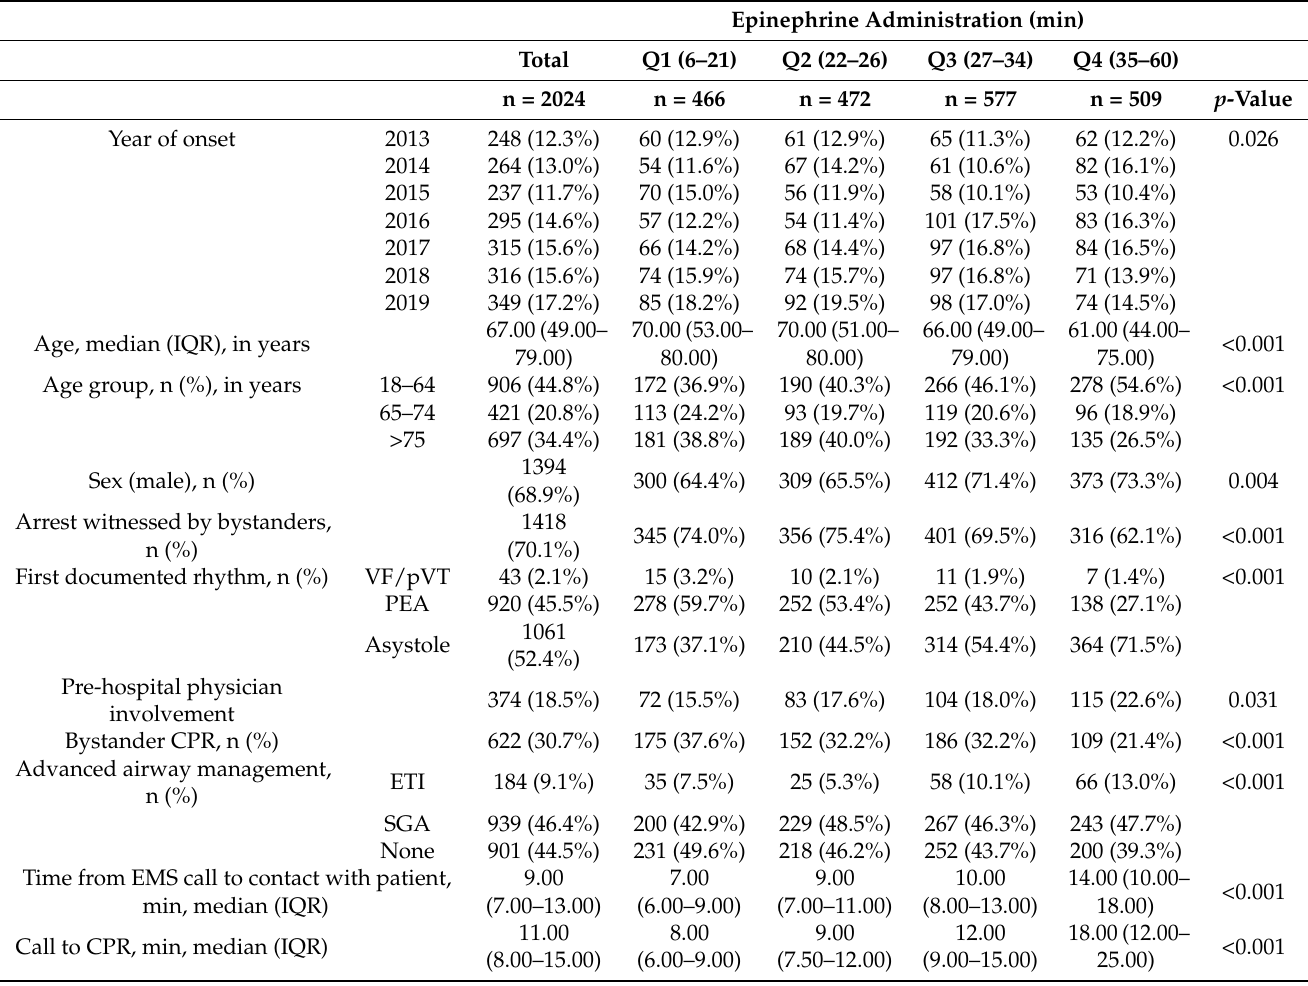
Table 1. The characteristics of patients with epinephrine